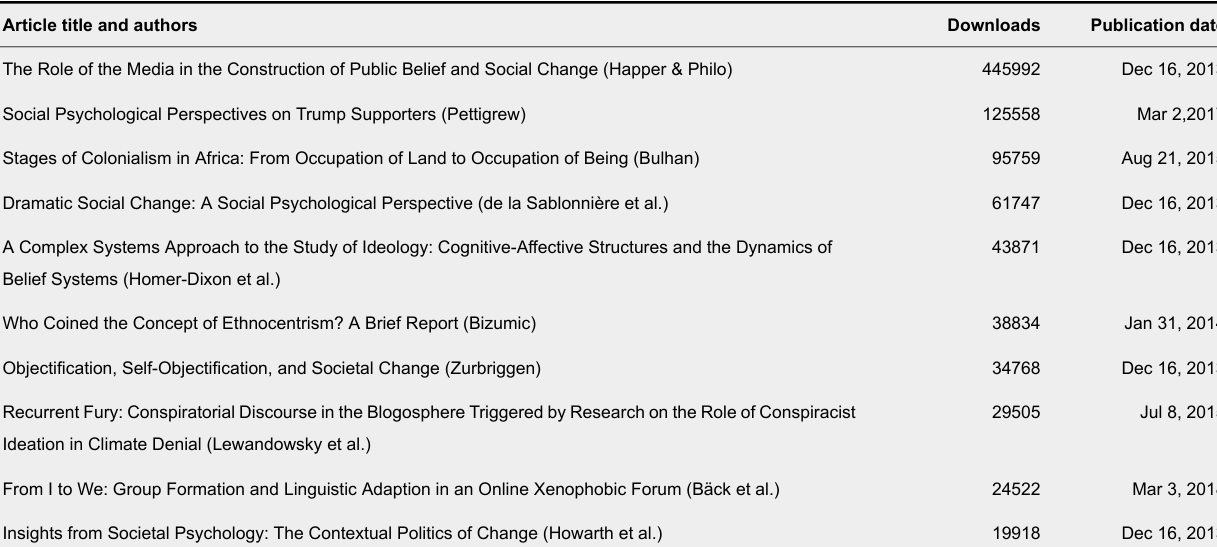
Top Ten Most Frequently Downloaded Articles Published Between 2013 and